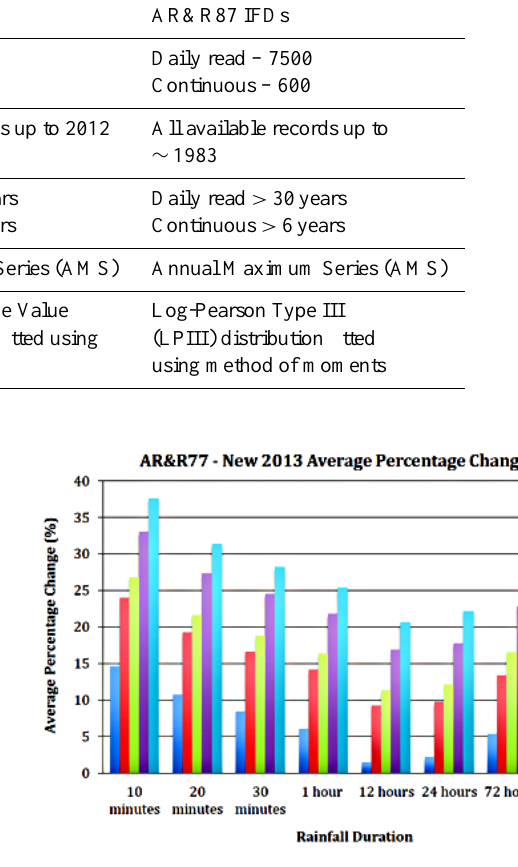
Figure 4. Average percentage change in rainfall intensities between AR&R77 and 2013